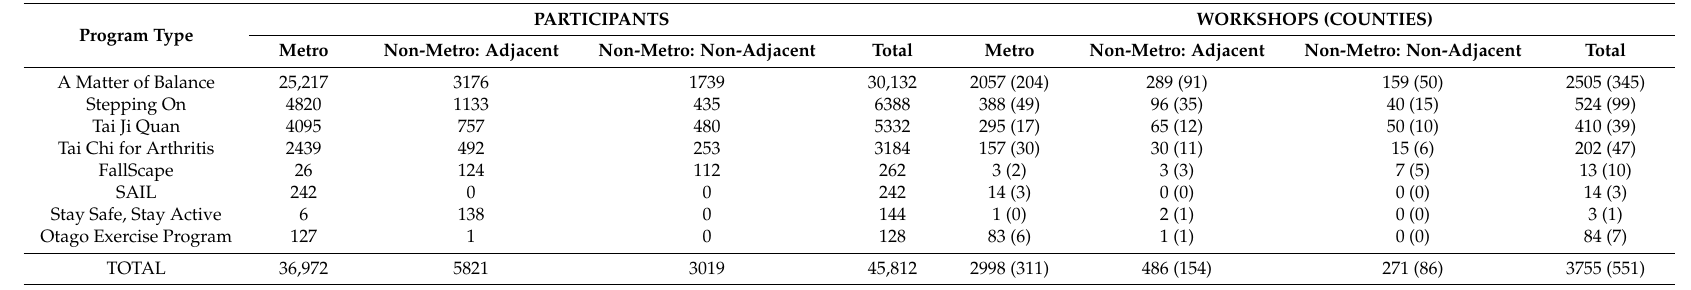
Table 1. Fall Prevention Program Workshop Types by Rurality.